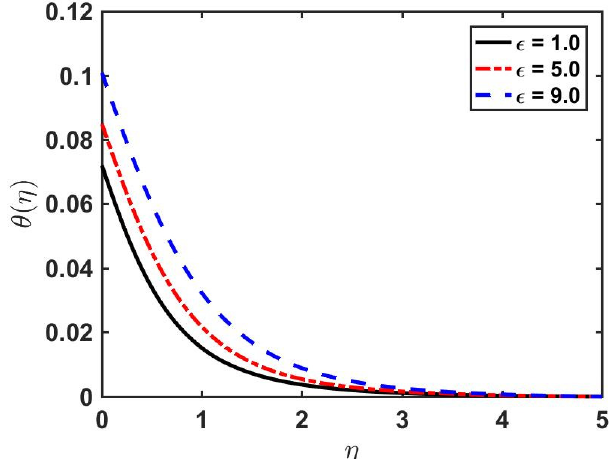
Figure 11. Effect of 𝝐 on 𝜽(𝜼) .